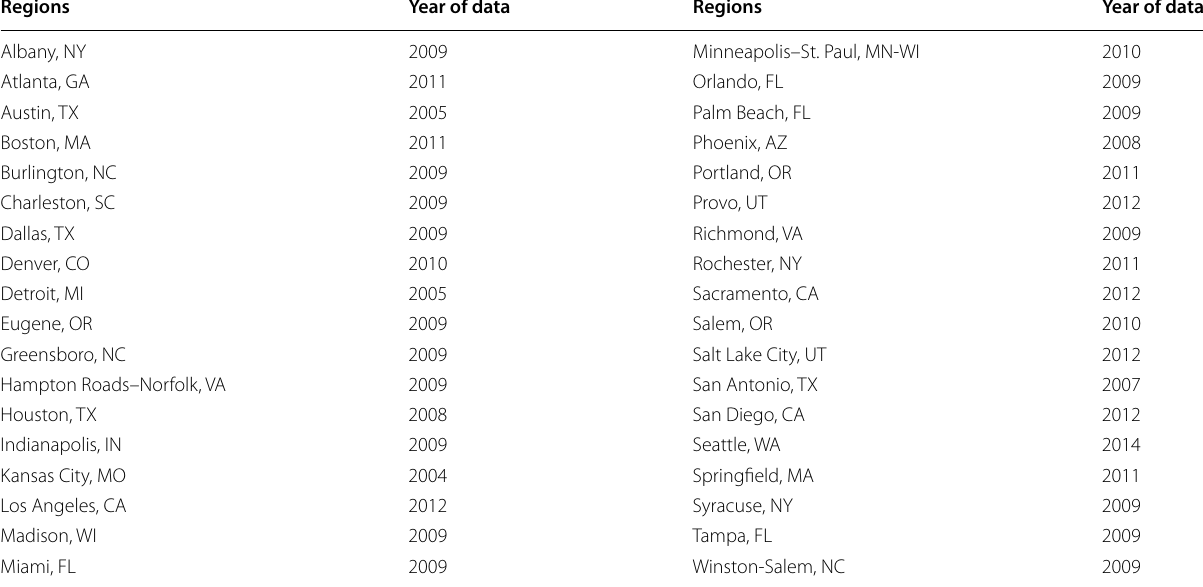
Table 1 Regions (metropolitan areas) in the dataset